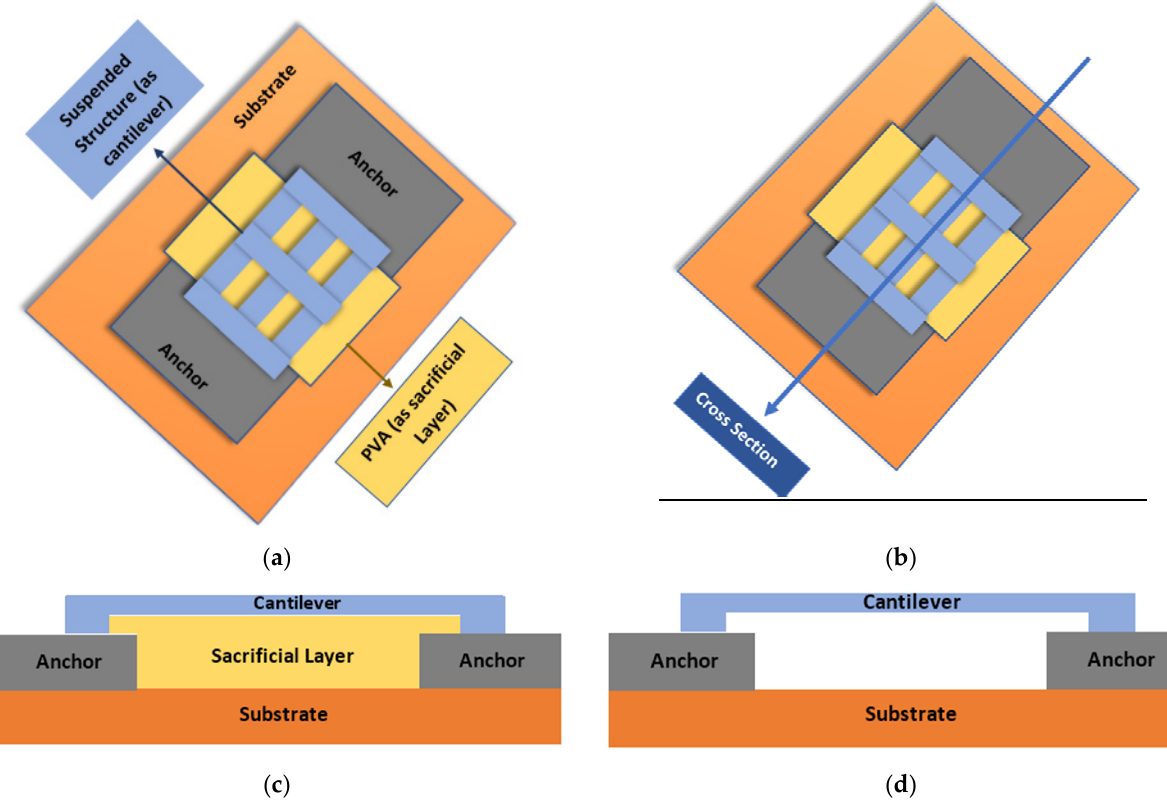
Figure 11. Schematic of a suspended structure where printed PVA used as a sacrificial material. ( a ) schematic and top view of the suspended structure; ( b ) the region from where the cross-section was taken, ( c ) structure before the final removal of the PVA sacrificial layer and ( d )final suspended structure after the removal of sacrificial